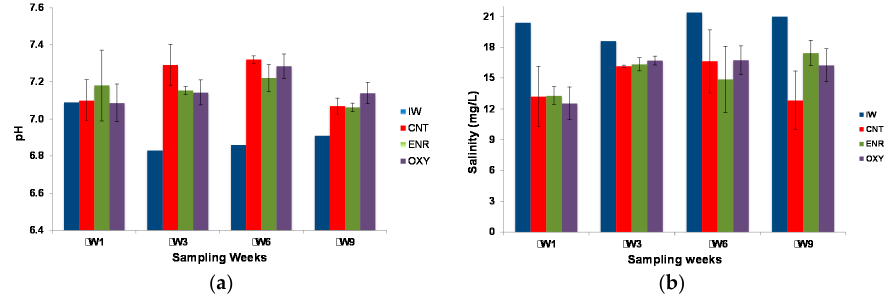
Figure 2. Values of ( a ) pH and ( b ) salinity measured in the initial (IW) and treated wastewaters along the sampled weeks. Wastewater not doped (CNT) or doped with the antibiotic enrofloxacin (ENR) or oxytetracycline (OXY).